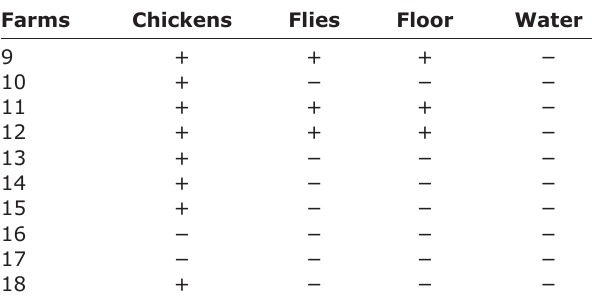
Table-2: Occurrence of H. pullorum isolates in broiler chickens and environmental samples in 10 farms. Farms Chickens